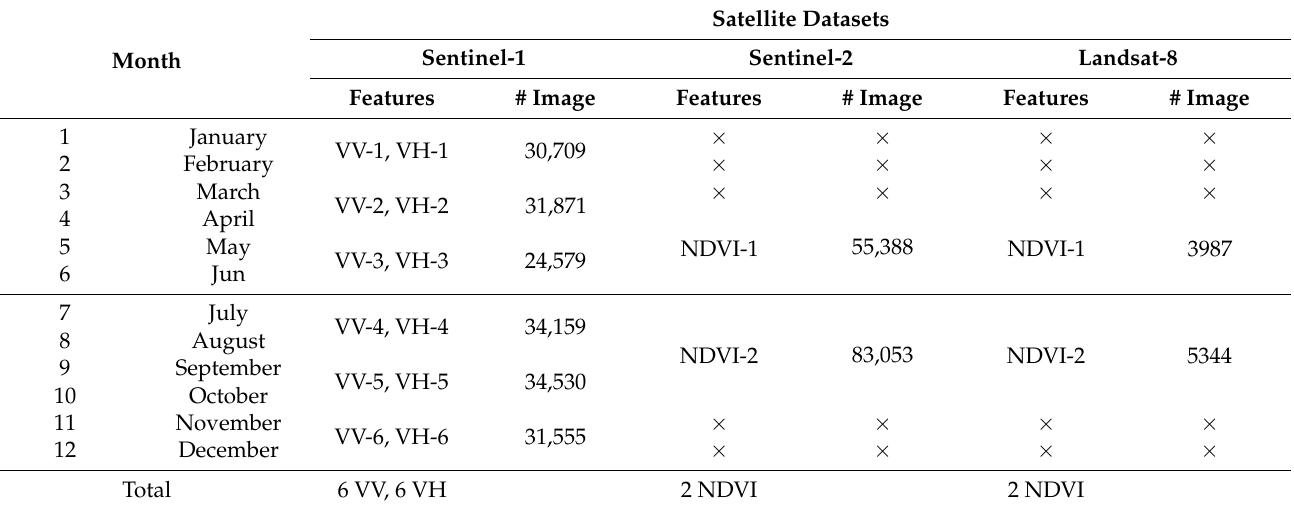
Table 3. The number of satellite images from 2016 to 2021 (e.g., Sentinel-1, -2, and Landsat-8) utilized for providing features after the preprocessing procedure.